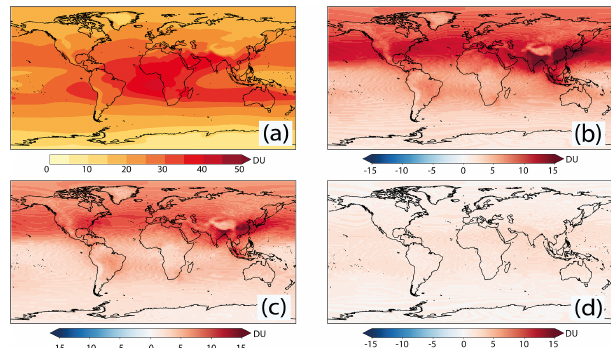
Figure 9. Global distributions of tropospheric O 3 column (a) in piClim-control . Differences with respect to piClim-control from piClim-O3 , piClim-NOx and piClim-VOC can be seen in panels (b) , (c) , and (d) , respectively. Units in Dobson units